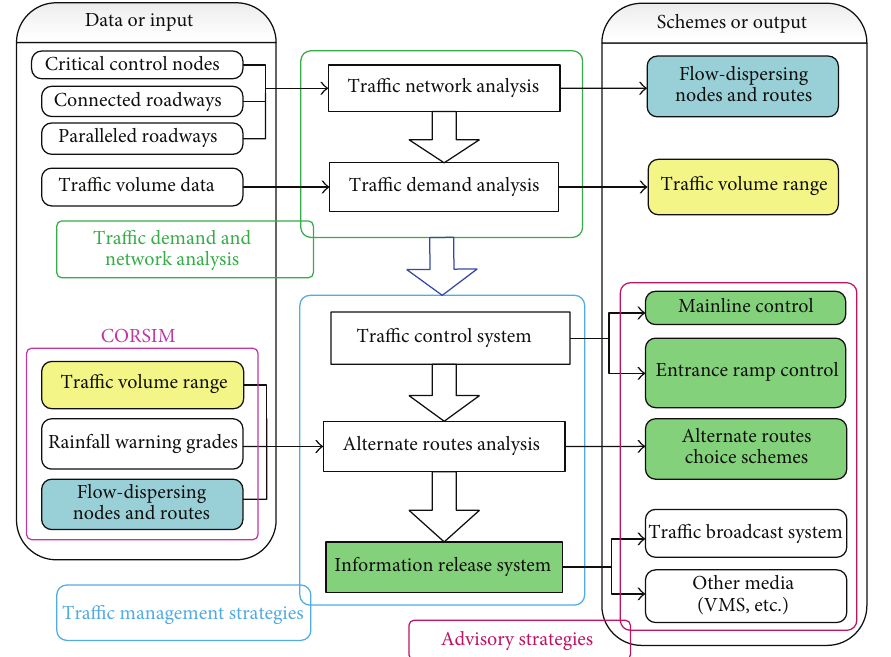
Figure 2: Framework for the proposed traffic management system under adverse weather events.